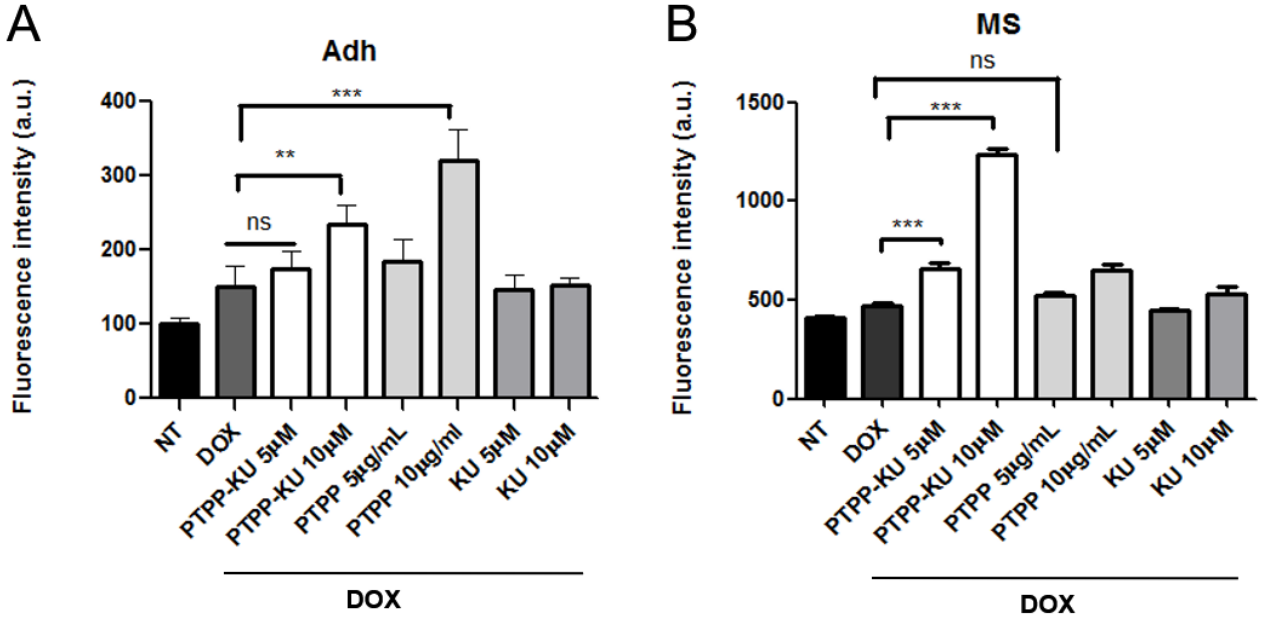
Figure 3. Doxorubicin internalization compared with non-treated (NT) cells. ( A ) Adherent cells (Adh) and ( B ) mammospheres (MS) in 96 well plates were treated with KU (5, 10 µ M), PTPP (5, 10 µ g/mL), and PTPP–KU (KU: 5, 10 µ M; PTPP 5, 10 µ g/mL) for 30 min before adding DOX, 1 µ M. After 3 h, the wells were washed with RPMI without phenol red, and the DOX concentration was measured with an Infinite M200 plate reader (Tecan, Switzerland, λ ex = 510 nm, λ em = 580 nm) and expressed as fluorescence intensity in arbitrary units (a.u.). The results are expressed as the mean ± SD for at least three independent experiments and were analyzed using a Student’s t -test (** p < 0.01, *** p < 0.001, ns not significant). Statistical analysis is not shown if it is not considered significant ( n = 3).